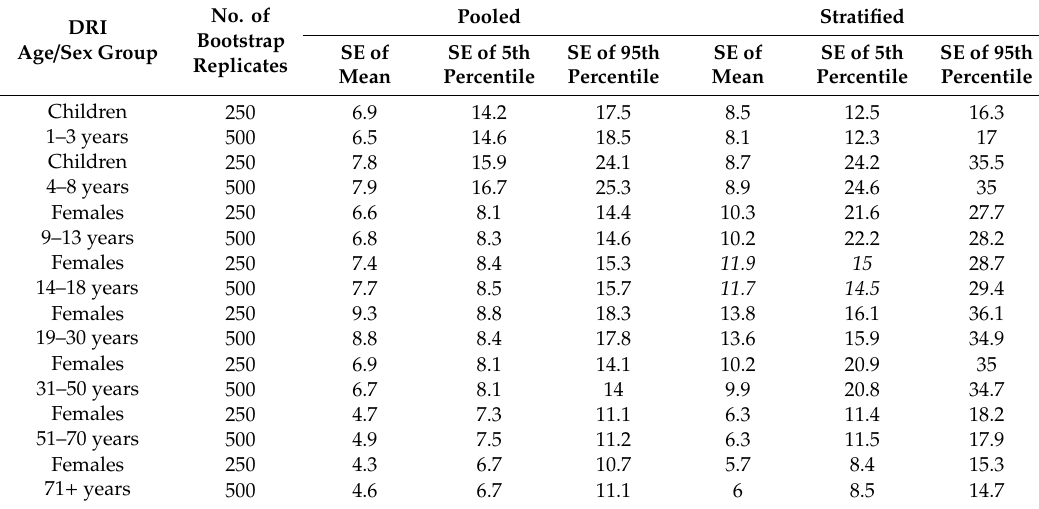
Table 3. Comparison of standard errors (SE) of distributional estimates of dietary folate equivalents ( µ g / day)—Canadian Community Health Survey (CCHS)